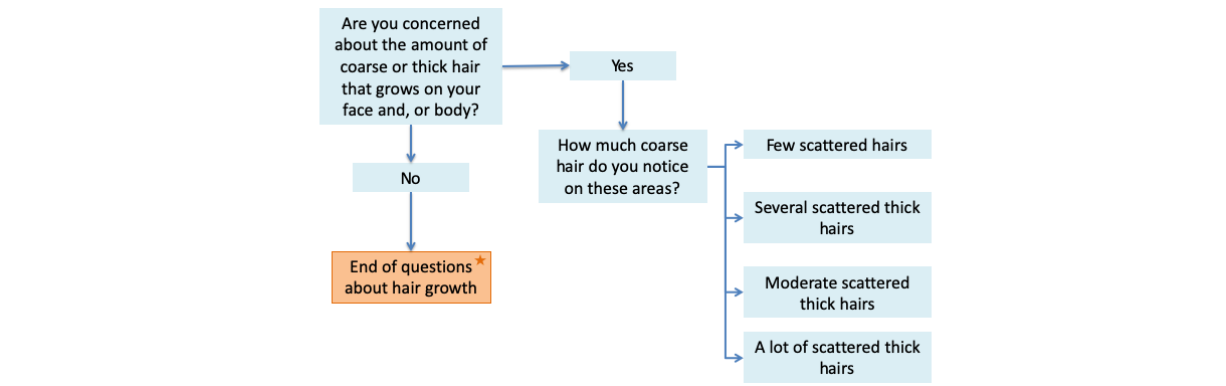
Figure 2. This figure highlights the adaptive nature of irregular cycle feature by modeling with questions assessing hair growth. The orange, starred box indicates the end of the question